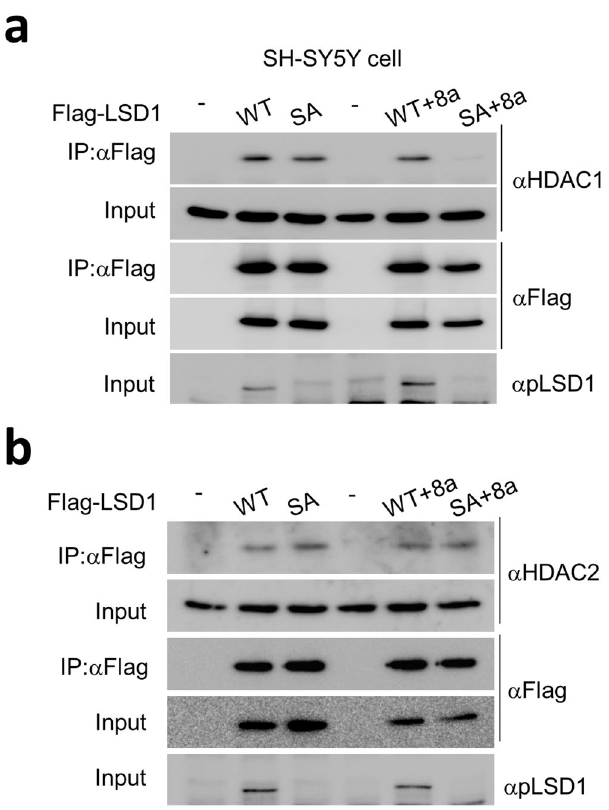
Figure 8. LSD1n-SA mutant show impaired interaction with HDAC1. ( a and b ) Co-immunoprecipitation assay of conventional LSD1-WT, -SA mutant and neuron-specific LSD1n-WT, -SA mutant with HDAC1 ( a ) or HDAC2 ( b ) in SH-5YSY cells. Full blot images were included in the Supplementary Information